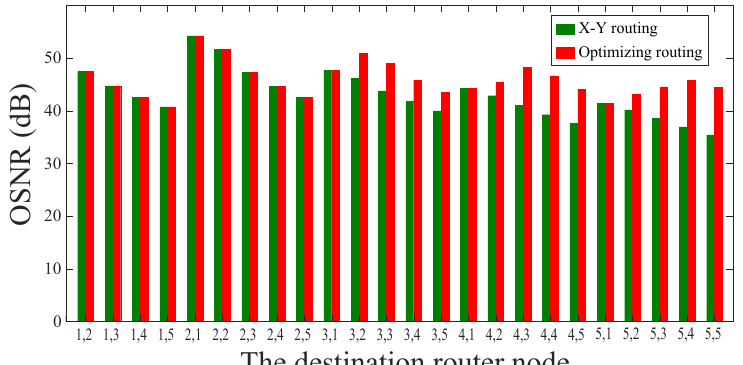
Figure 7. OSNR comparison between traditional routing algorithm and our optimization algorithm in a 5 × 5 mesh-based ONoC.